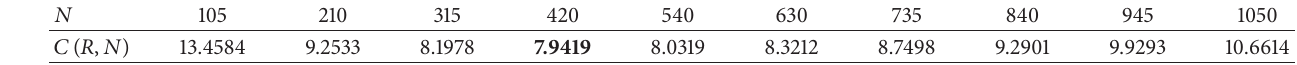
Table 2: Some results obtained from proposed policy when 𝑅 = 0.9 .